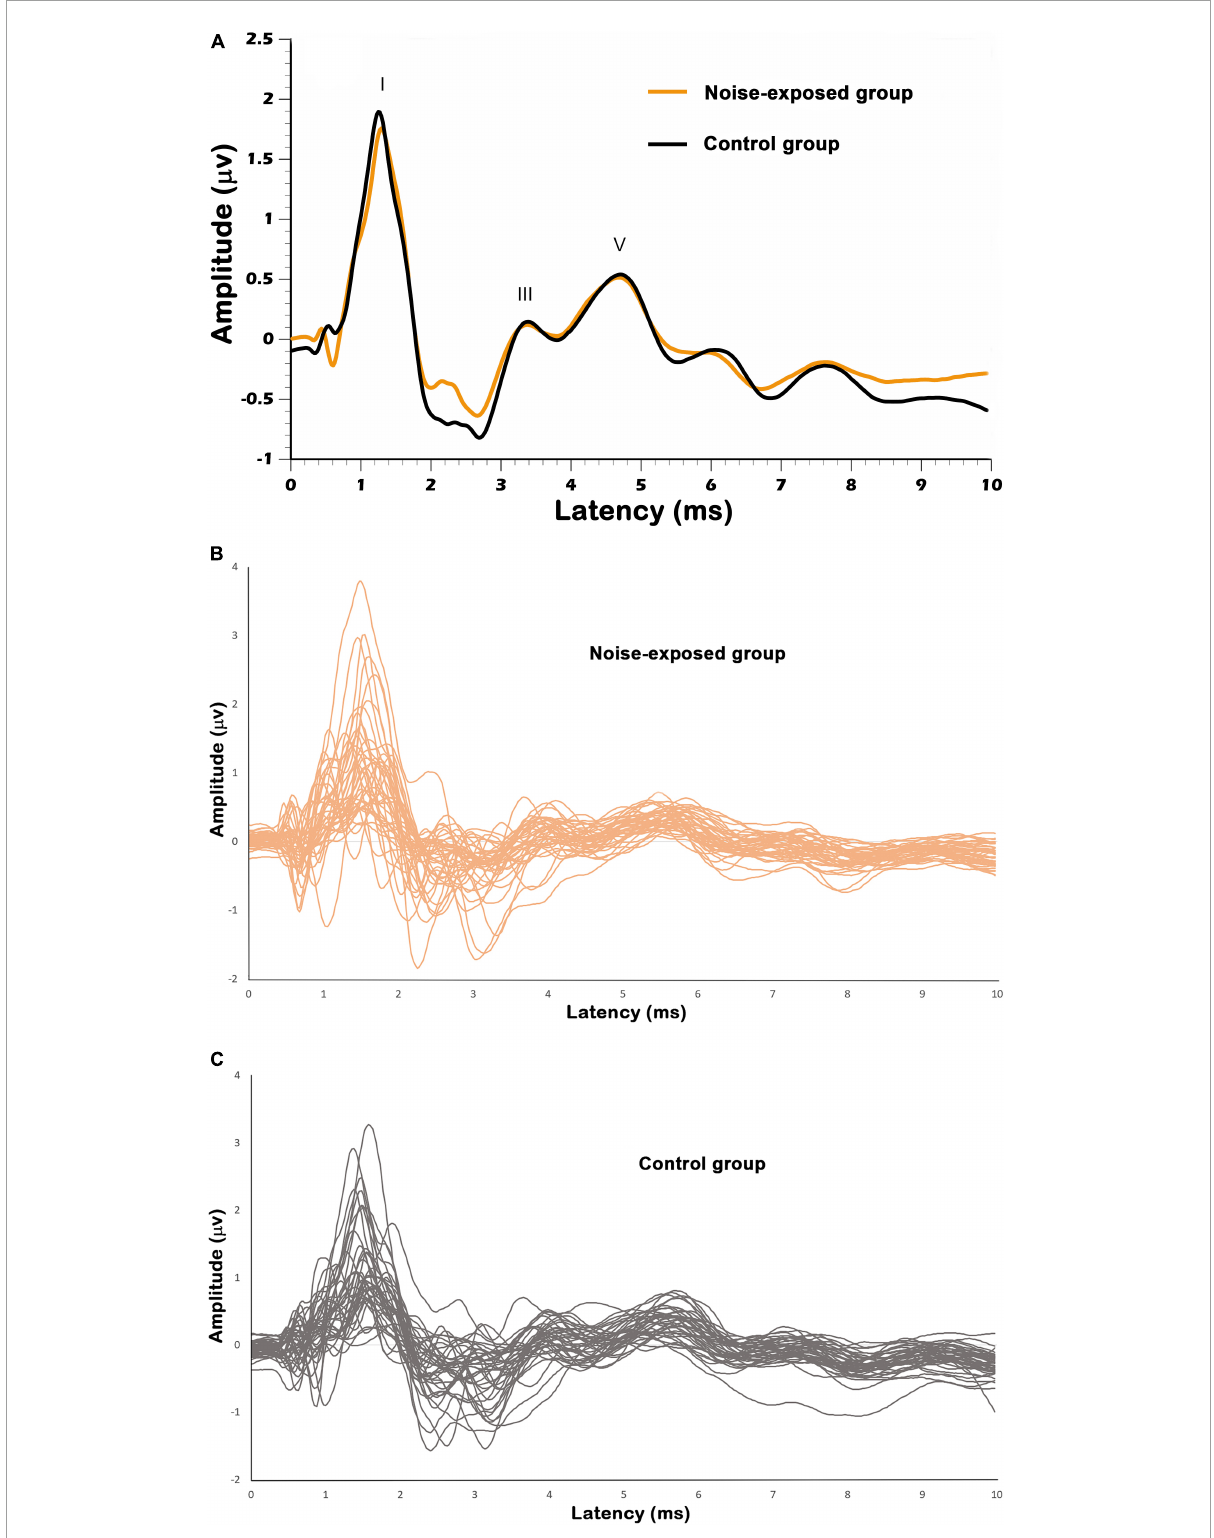
FIGURE3 (A) Grand mean ABR triggered by click stimulus at 90 dBnHL for the noise-exposed and control group. The individual ABR waveforms are also illustrated in (B,C) for noise-exposed and control groups. Surface electrodes were placed at the vertex (Cz, non-inverting electrode) and the forehead (Fpz, ground), while an extra-tympanic electrode (inverting electrode) was placed sitting at the tympanic membrane. I, III, and V denote wave I, wave III, and wave